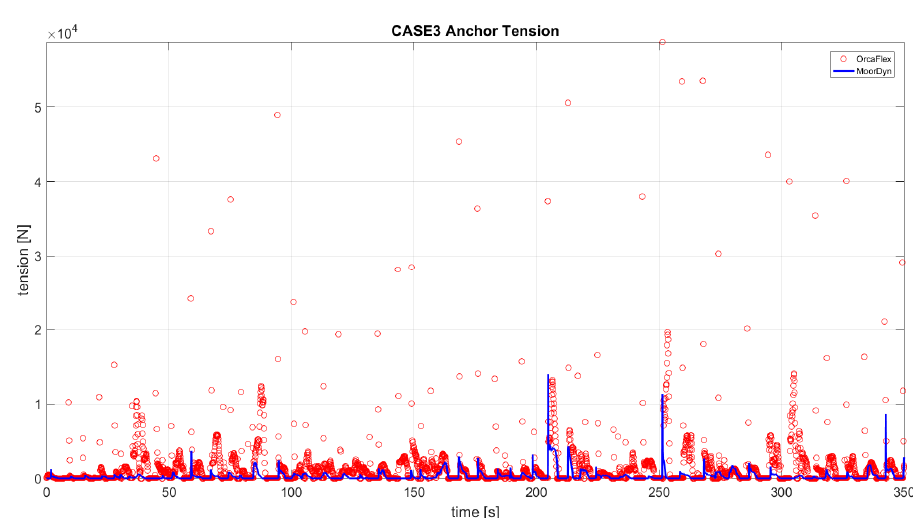
Figure 13. Simulation case 3: Time series of anchor tension.